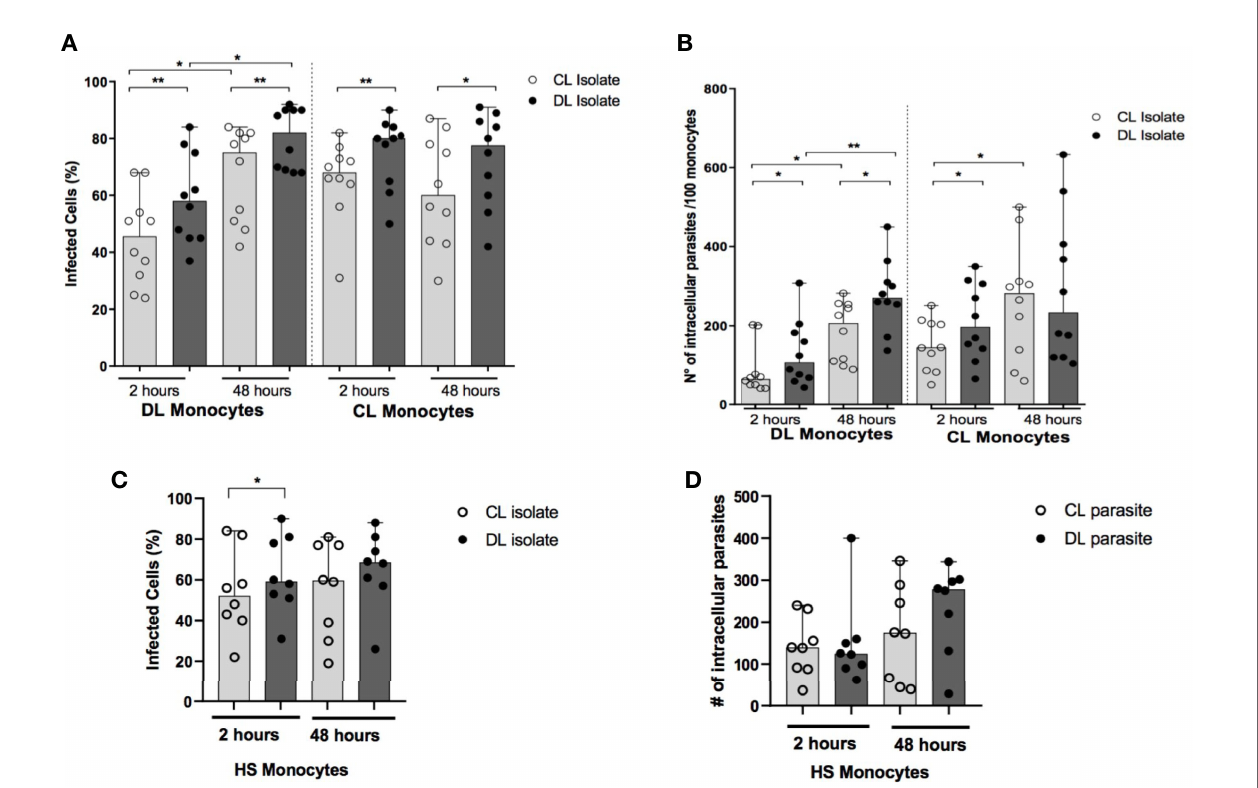
FIGURE 2 | Frequency of infected monocytes and parasite load after infection with different isolates of L. braziliensis : PBMC from patients with DL (n=12),CL (n=12) and HS (n=8) were infected with different isolates of L. braziliensis at a ratio of 5:1 for 2 h or 48 h. The number of infected cells (A, C) and the number of intracellular parasites (B, D) were evaluated by optical microscopy in 100 monocytes following Romanowsky staining. P values were calculated using Wilcoxon ’ s signed-rank for analyses within the same clinical form, while comparisons between different clinical forms were assessed using the Mann-Whitney test (*p < 0.05) (**p <